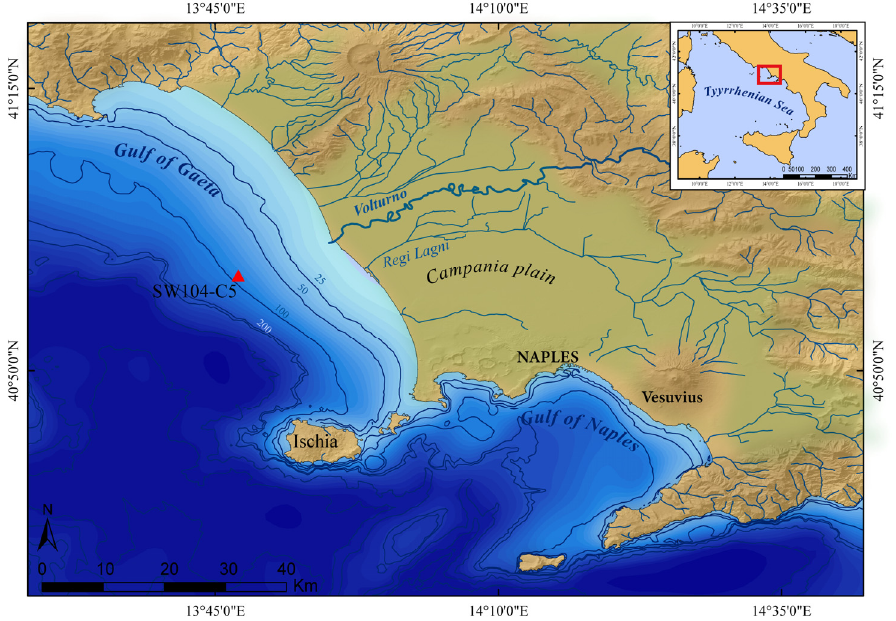
Figure 1. Location map of the Gulf of Gaeta (central Tyrrhenian Sea, Southern Italy) and the position of the SW104-C5 core.